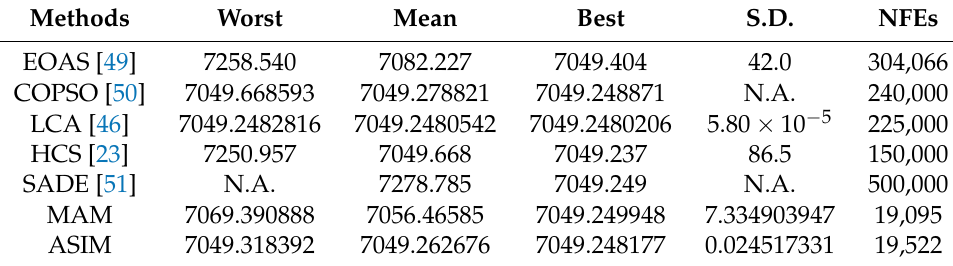
Table 12. Statistical features of the results obtained by various algorithms on